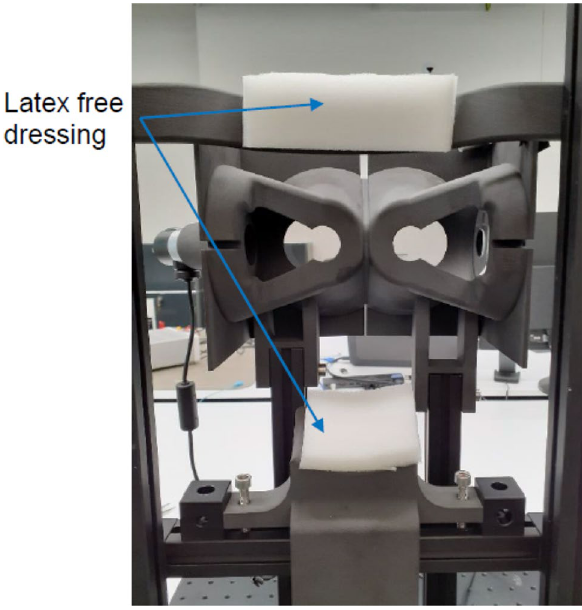
Figure 1. A non-wearable augmented reality (ANWAR) optical